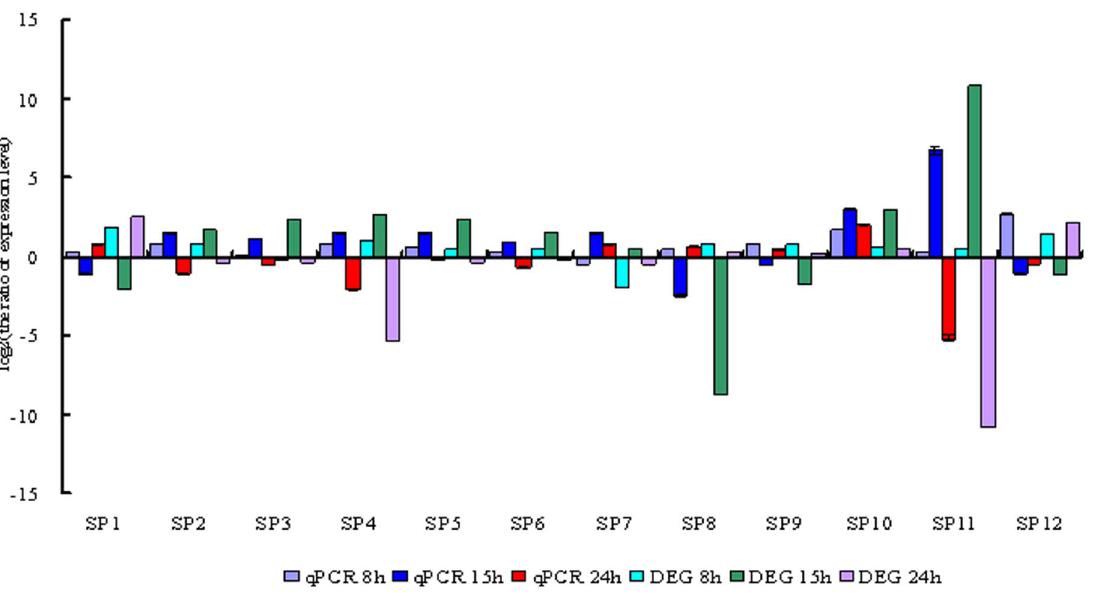
Figure 5. Comparation of Real-time qPCR detection with DGE profiling. SP1: neutral lipase. SP2: Bm8 interacting protein 2d-4 precursor. SP3: glucose transporter. SP4: hypothetical protein KGM_13211. SP5: troponin C. SP6: ecdysone-induced protein 63F 1. SP7: amidase. SP8: vacuolar ATP synthase subunit D. SP9: serine protease 13. SP10: putative protein phosphatase-5. SP11: hemolymph proteinase 18. SP12: peptidoglycan recognition protein S6 precursor.